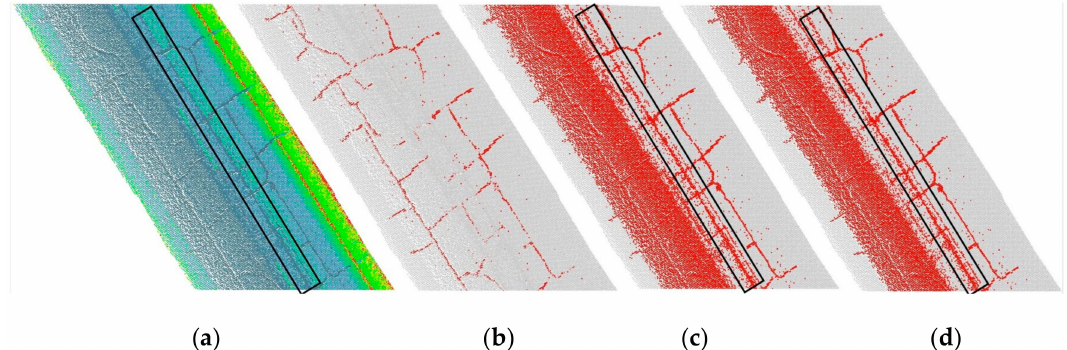
Figure 15. The detected crack candidates by using di ff erent methods. ( a ) Original point cloud, ( b ) the detected crack candidates by using the proposed method, ( c ) by using the maximum entropy sum method, and ( d ) by using Otsu’s thresholding